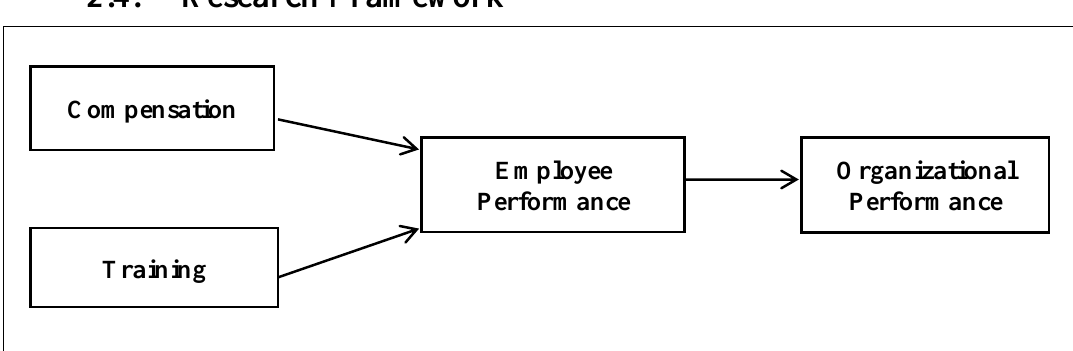
Figure.1. Conceptualized